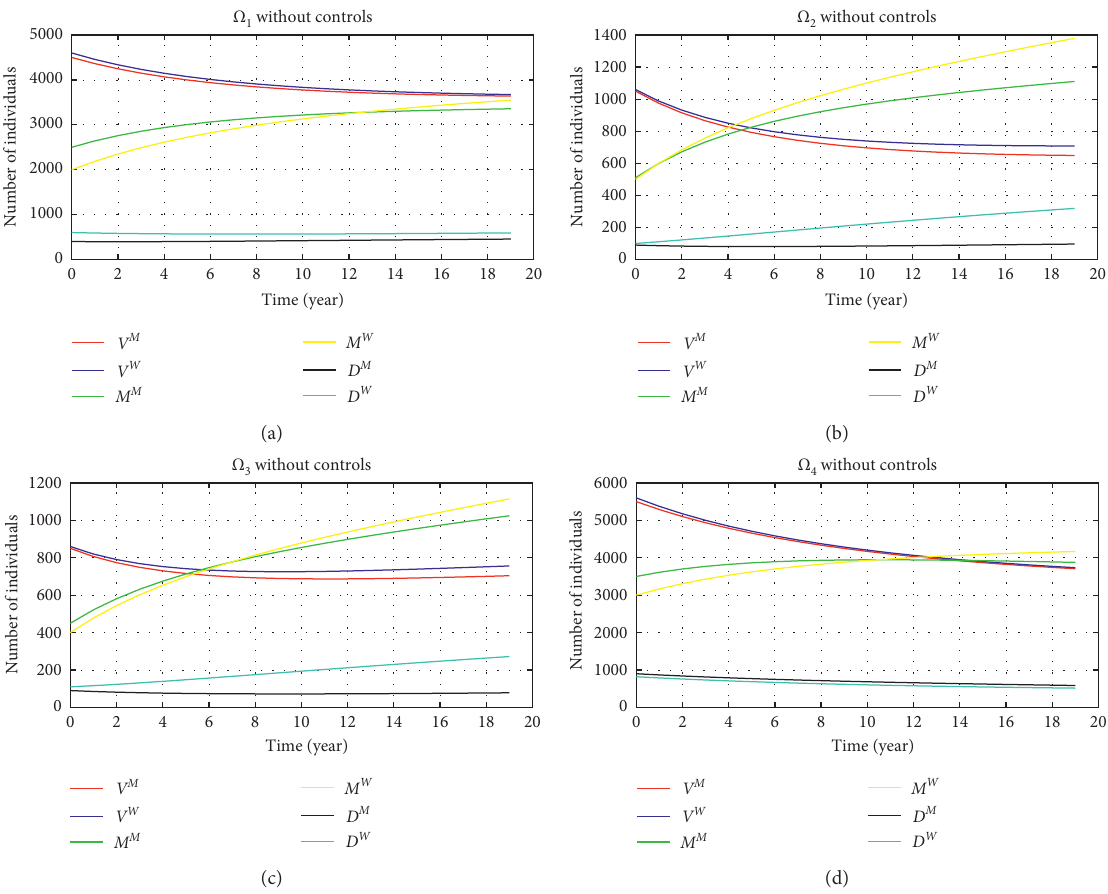
Figure 1: Time evolution of marital status of family dynamics VMDW without controls.